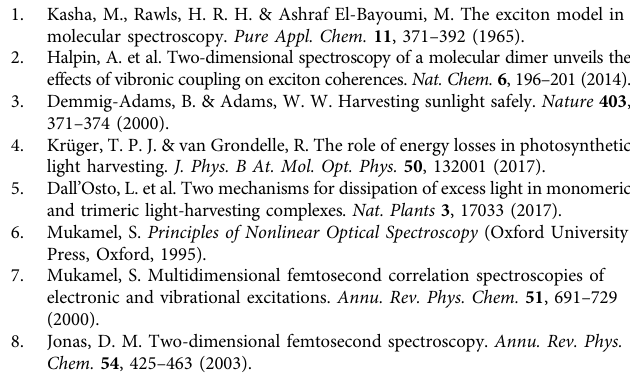
the curves in Fig. 6a deviate systematically from each other, the remaining deviations in Fig. 6b constitute purely random noise (except for the short-time behavior of the blue curve), validating experimentally the correctness of our analysis. Note that the reconstruction of an annihilation-free third-order signal works deviations of the high-energy blue curve are most likely caused by